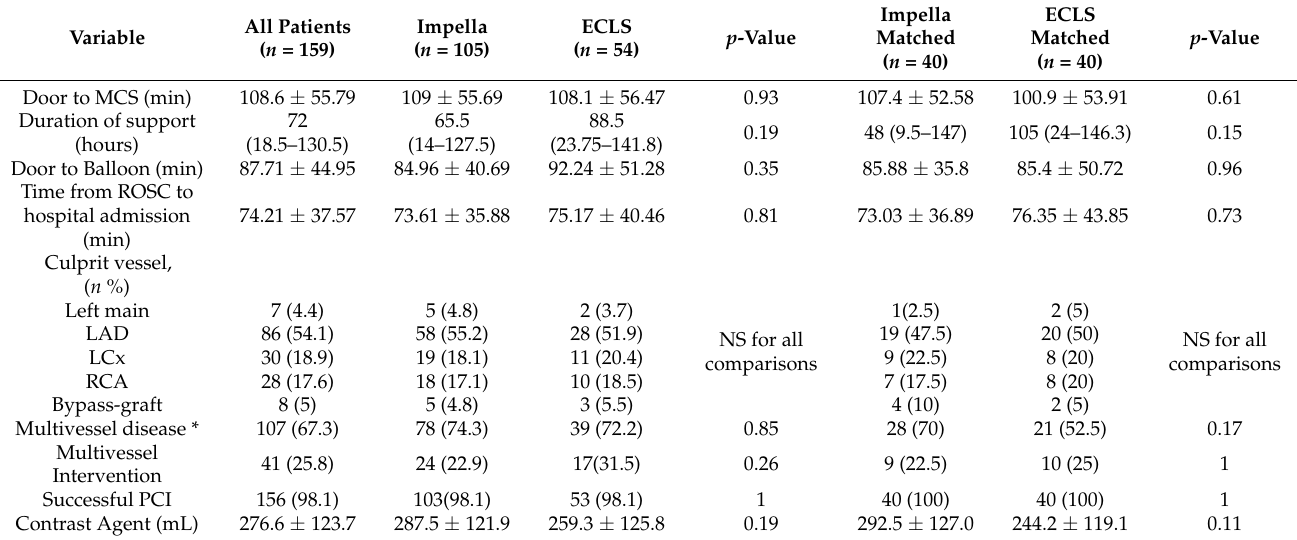
Table 2. Procedural characteristics of the total group and matched cohorts.